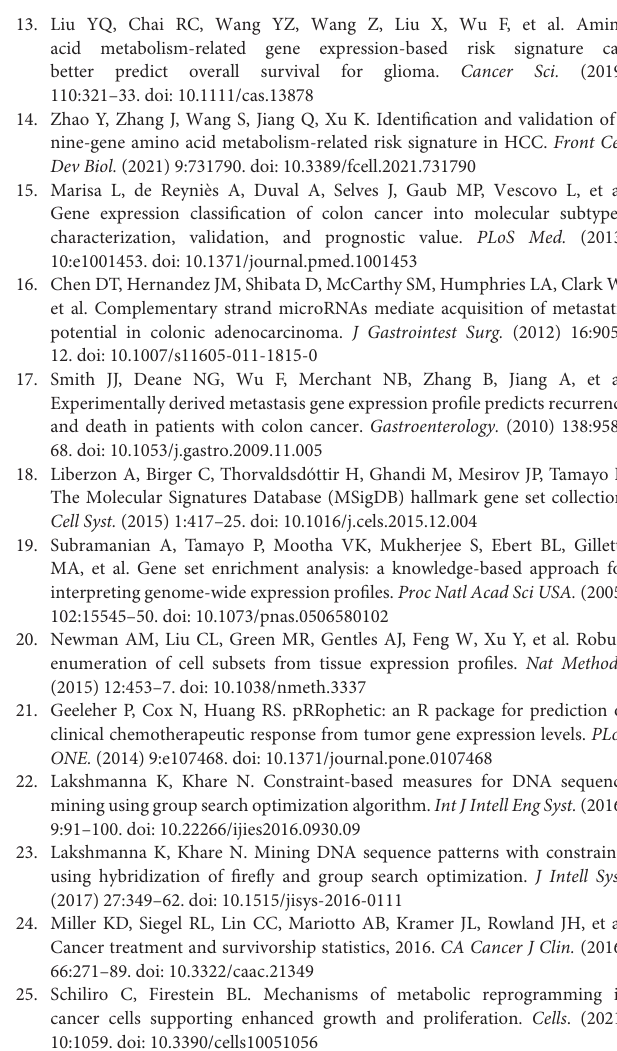
Supplementary Figure S1 | Kaplan-Meier survival subgroup analysis according to the signature stratified by clinical characteristics. (A) Age ≤ 70 years and age > 70 years. (B) Female and male. (C) T1-2 and T3-4. (D) N0 and N1-2. (E) M0 and M1. (F) Stage I–II and stage III–IV. Supplementary Figure S2 | Correlation between risk score and GSEA, somatic variation. (A) Enriched gene sets annotated by the KEGG collection between the high- and low-AAMRGs-risk groups in the cohort. (B) TMB levels between the high- and low-risk groups. (C) Correlation analysis between risk score and mutation load. (D,E) The mutation rates of reported prognostic-related genes in low- and high-risk groups. Supplementary Figure S3 | Differential chemotherapeutic response based on IC50 available between the high- and low-risk groups. (A–F) The